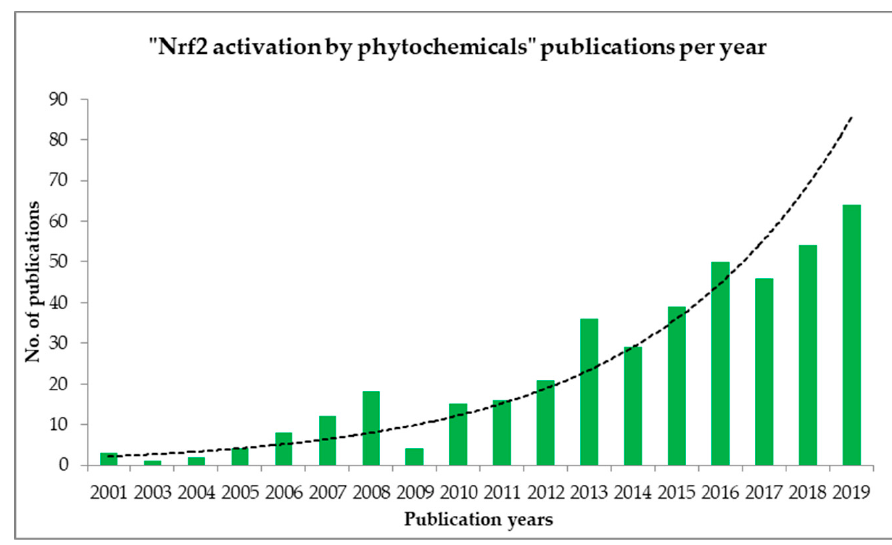
Figure 4. Exponential interest in the scientific community towards searching for Nrf2 activators from natural phytochemicals during the last 20 years (2001 to 2019). PubMed database shows that in the first six months of 2020, there were 35 articles published.